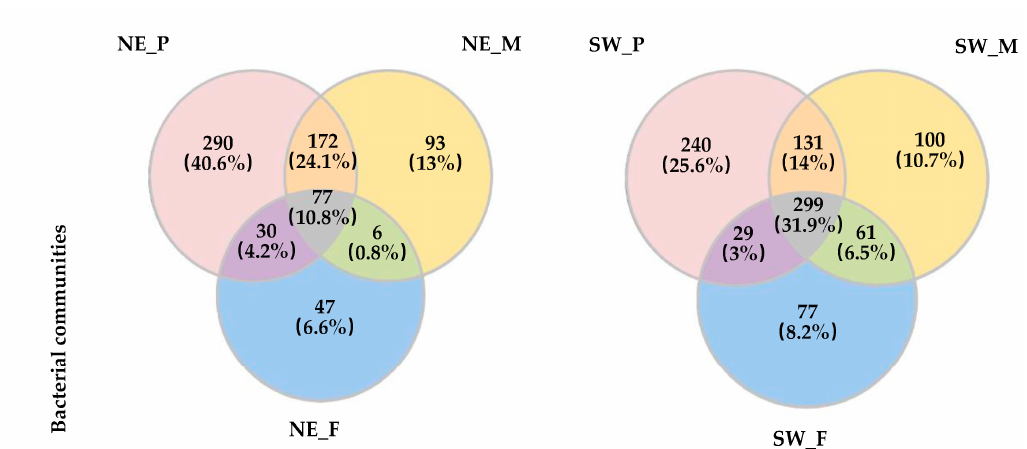
Figure 2. Overview of viral and bacterial communities. ( a ) The distribution of six soil virome communities. ( b ) Ternary plot depicting compartment at species level within different land use patterns. ( c ) Venn diagram at species level. The numbers refer to the number of species and the numbers in parentheses refer to percentage. Figure 3. Redundancy analysis on the relationship between soil chemical properties and viral